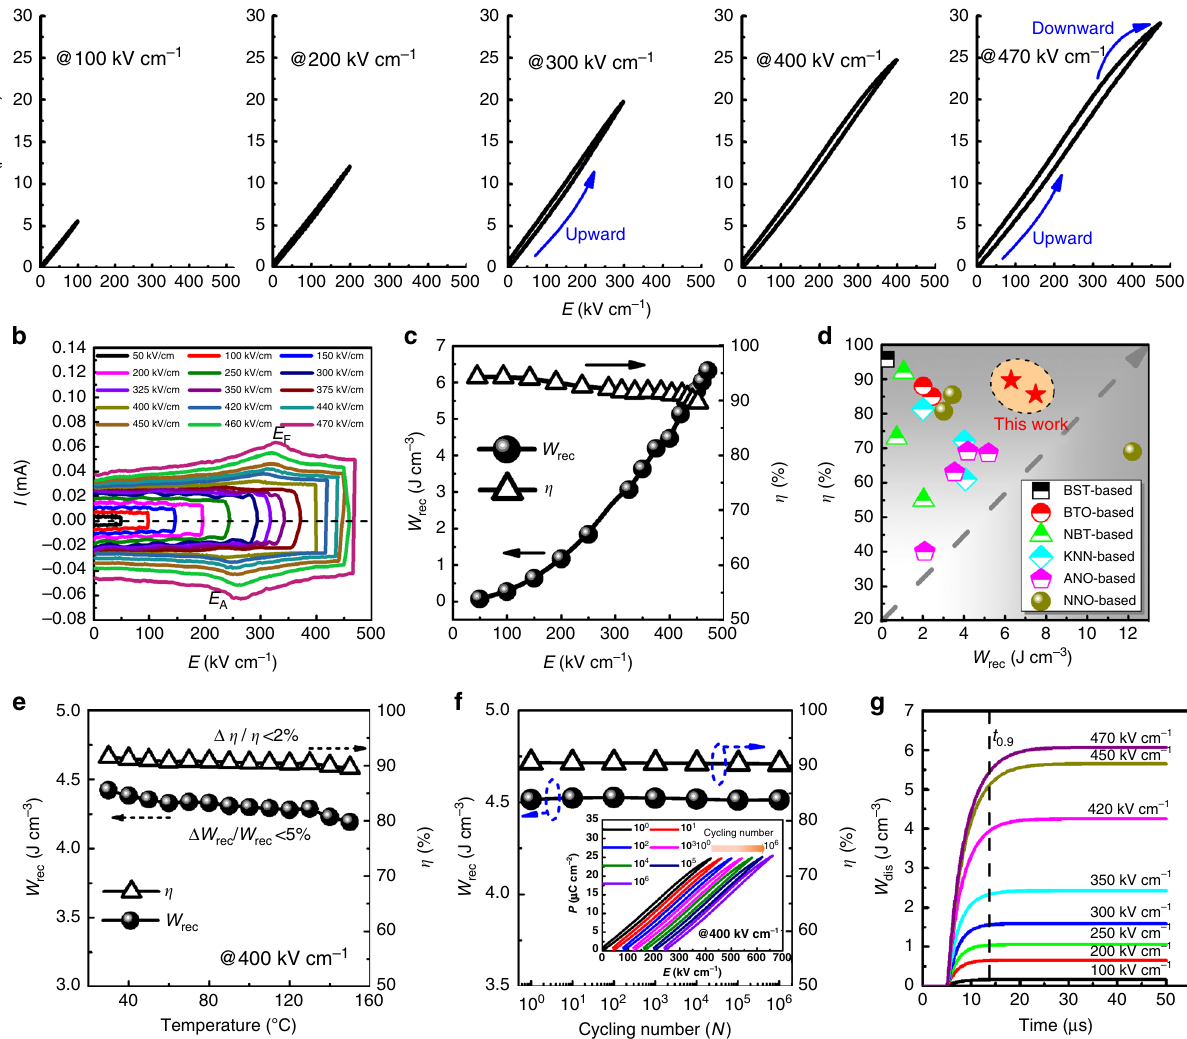
Fig. 4 The reliability of energy storage performance under various conditions for the ANT55 ceramic with thickness of ~0.15 mm. The electric fi eld dependence of a P – E loops, b I – E curves, and c W rec and η values. d A comparison of the energy storage properties of ANT55 and the state-of-the-art dielectric bulk ceramics. BST, BTO, NBT, KNN, ANO, and NNO represent Sr 0.7 Ba 0.3 TiO 3 , BaTiO 3 , Bi 0.5 Na 0.5 TiO 3 , K 0.5 N 0.5 NbO 3 , AgNbO 3 , and NaNbO 3 , respectively. e Temperature dependence of W rec and η under an electric fi eld of 400kV cm − 1 . f The room temperature W rec and η as a function of the cycling number under an electric fi eld of 400 kVcm − 1 . The inset gives the typical P – E loops after various cycling numbers. g The time dependence of discharge energy density under various electric fi elds, measured by an RC load circuit. The load resistance is 13 k Ω breakdown strength of 530 kV cm − 1 with the maximum polarization of 32 μ C cm − 2 is achieved in sample with thickness of ~80 μ m and electrode diameter of 2 mm. This leads to improved energy storage density up to 7.5 J cm − 3 , meanwhile with yet high energy storage ef fi ciency of 86% (Supplementary Fig. 4). Compared with state-of-the-art lead-free bulk ceramics 17,20,24,25,29,40 – 49 , the ANT55 exhibits more attractive energy storage performance with both high energy storage density and ef fi ciency, as shown in Fig. 4d. From application viewpoint, the temperature stability and cycling reliability of energy storage properties are important 16,50 . The temperature-dependent energy storage property of ANT55 is evaluated at 400 kV cm − 1 to guarantee the safety in practical application, the corresponding results are given in Fig. 4e. The ANT55 exhibits very good temperature stability over temperature range of 25 – 150 °C, with minimal variations of <5 and <2% for energy storage density and ef fi ciency respectively. Figure 4f gives the cycling reliability of ANT55. Both energy storage density and